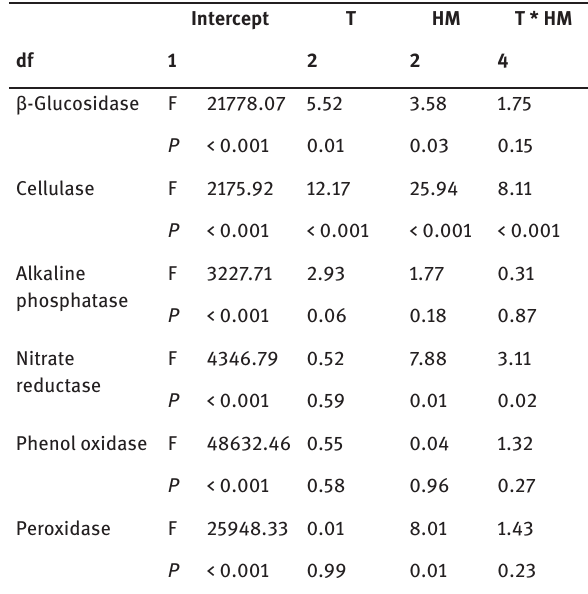
Table 2: Summary table for two-way ANOVAs performed on enzymatic activities, associated with Typha leaf sections incubated in microcosms at three temperatures (T) and two heavy metal (HM) levels for 100